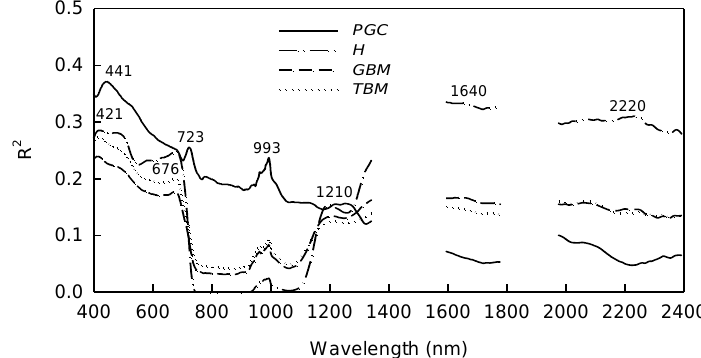
Figure 4. Variations of correlation coefficients of determination (R 2 ) with wavelength, showing the important wavelengths needed for estimating PGC (%), H (cm), GBM (g∙m −2 ), and TBM (g∙m −2 ) in Inner